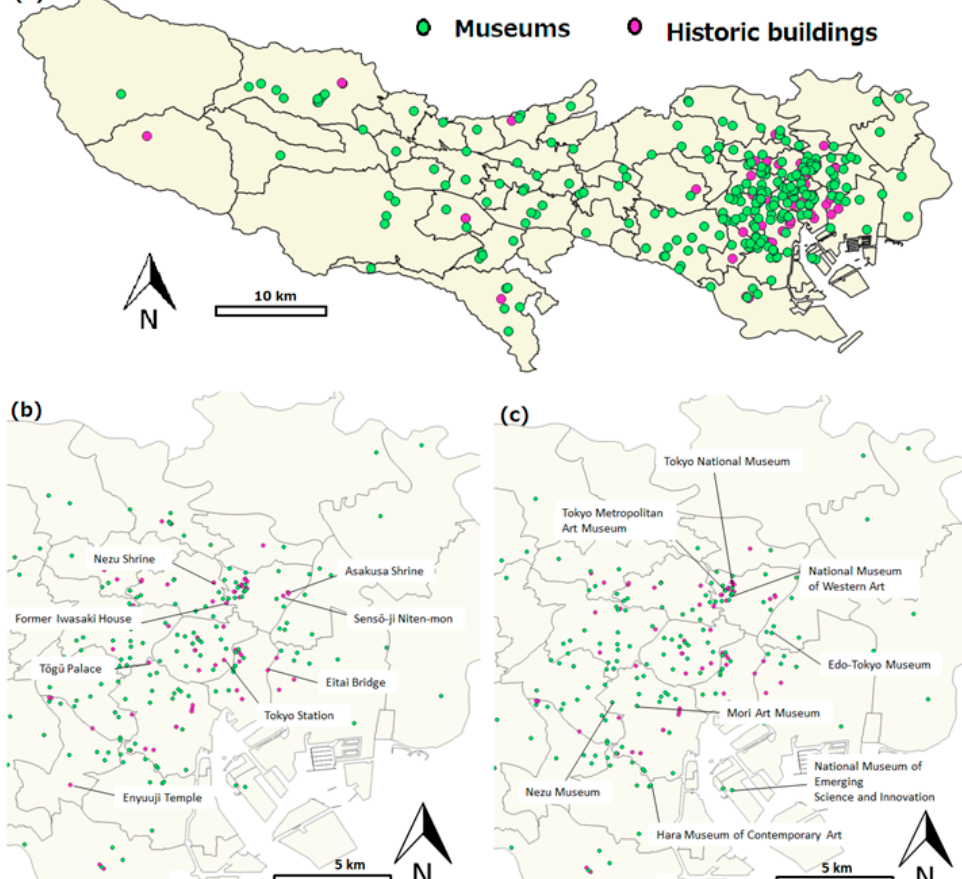
Figure 2. Location of ( a ) Historic buildings (pink) and museums (green) in Tokyo, ( b ) major historic buildings and ( c ) museums in central Tokyo. Note: Source: National Land Numerical Information (https://nlftp.mlit.go.jp/ [2] ).